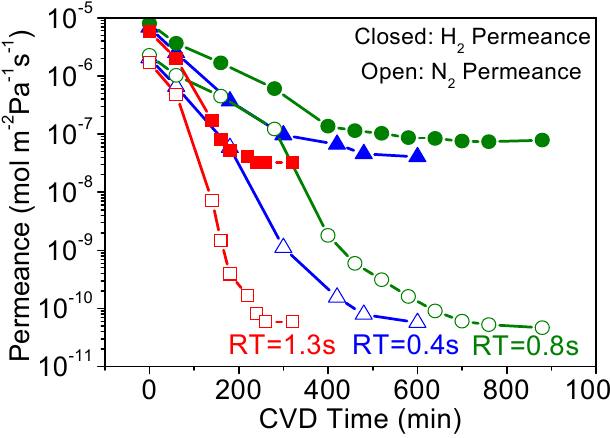
Figure 2. Changes in H 2 (closed symbols) and N 2 (open symbols) permeances during methyltrimethoxysilane (MTMOS) deposition at 650 °C with residence times of 0.4 s, 0.8 s, and 1.3 s. The residence time a ff ects the morphology of the membranes through the mechanism of